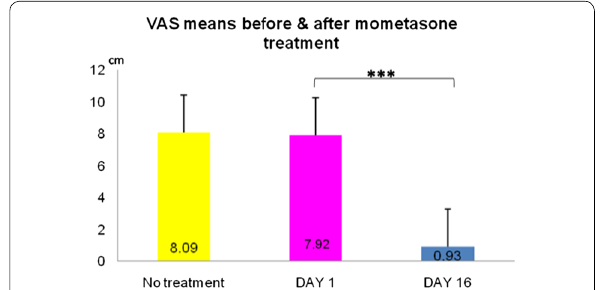
Fig. 1 VAS means before and after mometasone treatment